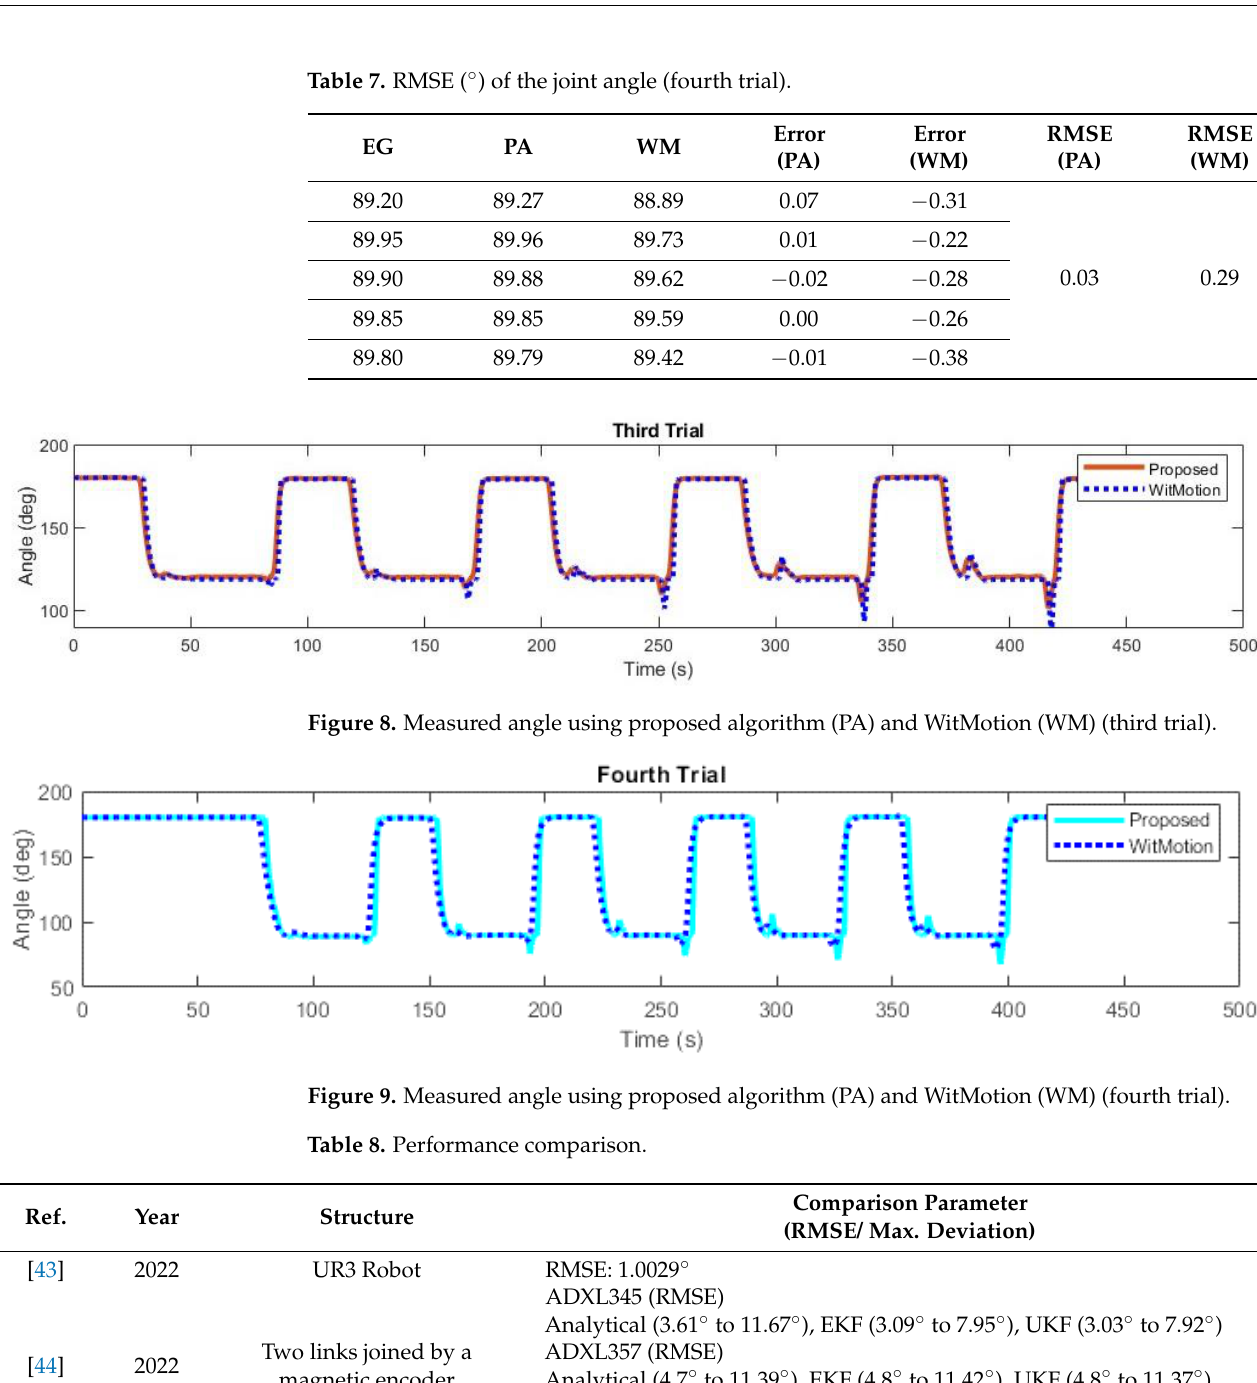
Table 5. RMSE ( ° ) of the joint angle (second trial).